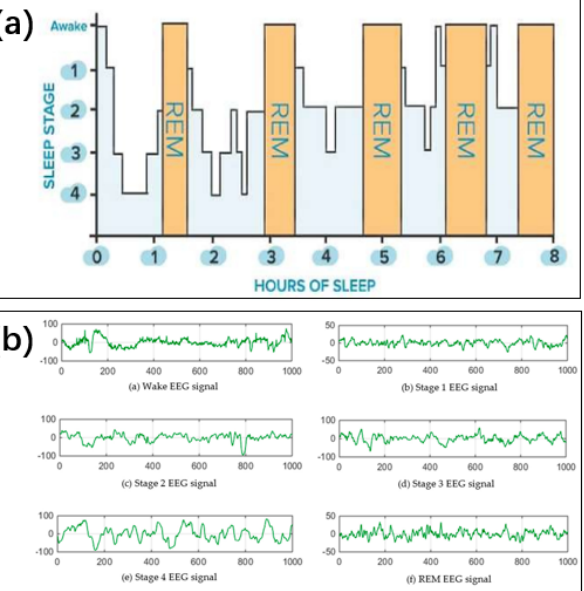
Figure 3. ( a ) Sleep cycles and REM sleep [41] . Reproduced under the terms of the CC-BY